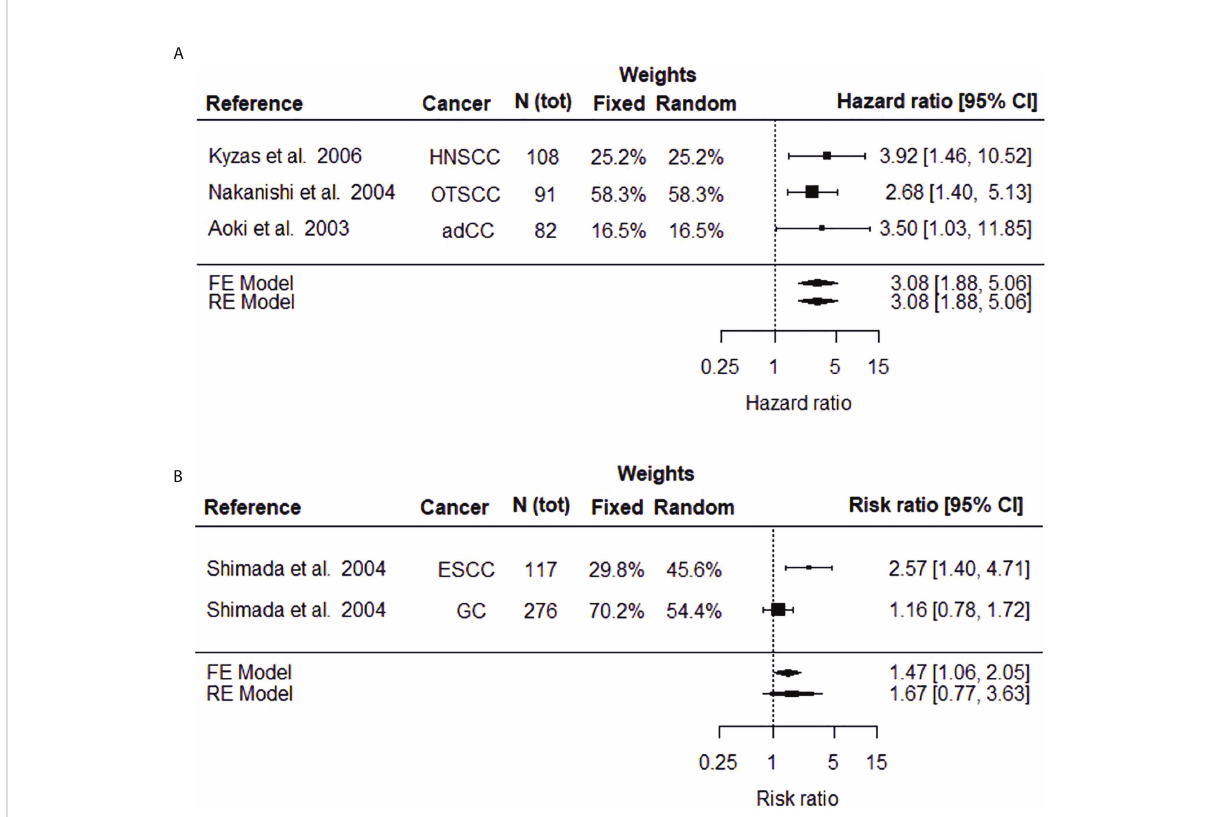
FIGURE 2 Forest plots depicting the meta-analysis results on high FXYD5 protein expression on risk of death estimated as hazard ratio (A) or risk ratio (B) . The black square displays the HR or RR identi fi ed in the study and the whiskers display the 95% con fi dence interval (CI). Size of the black box signi fi es the weight that the study contributes in the meta-analysis. The combined effect, estimated with both fi xed and random effects models, is displayed as the black